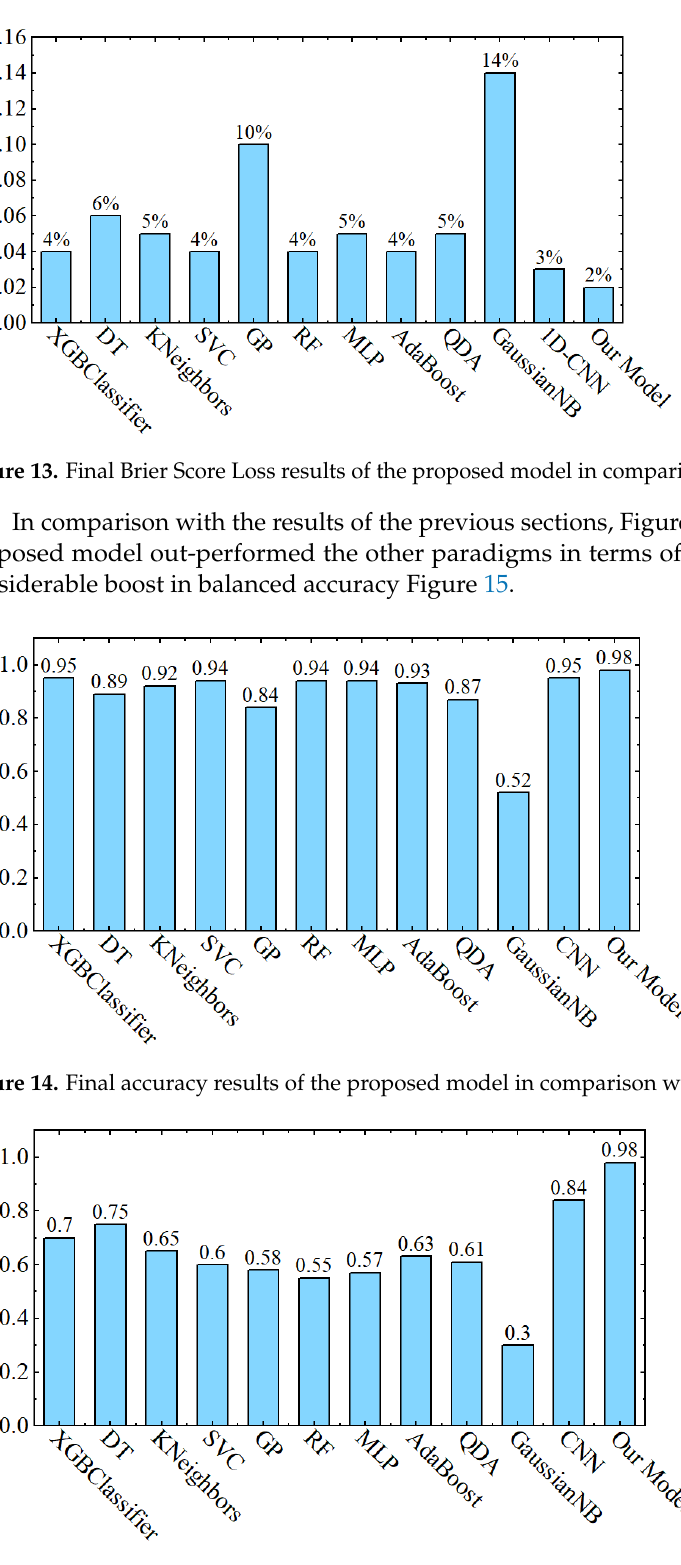
Figure 15. Final balanced accuracy results of the proposed model in comparison with other